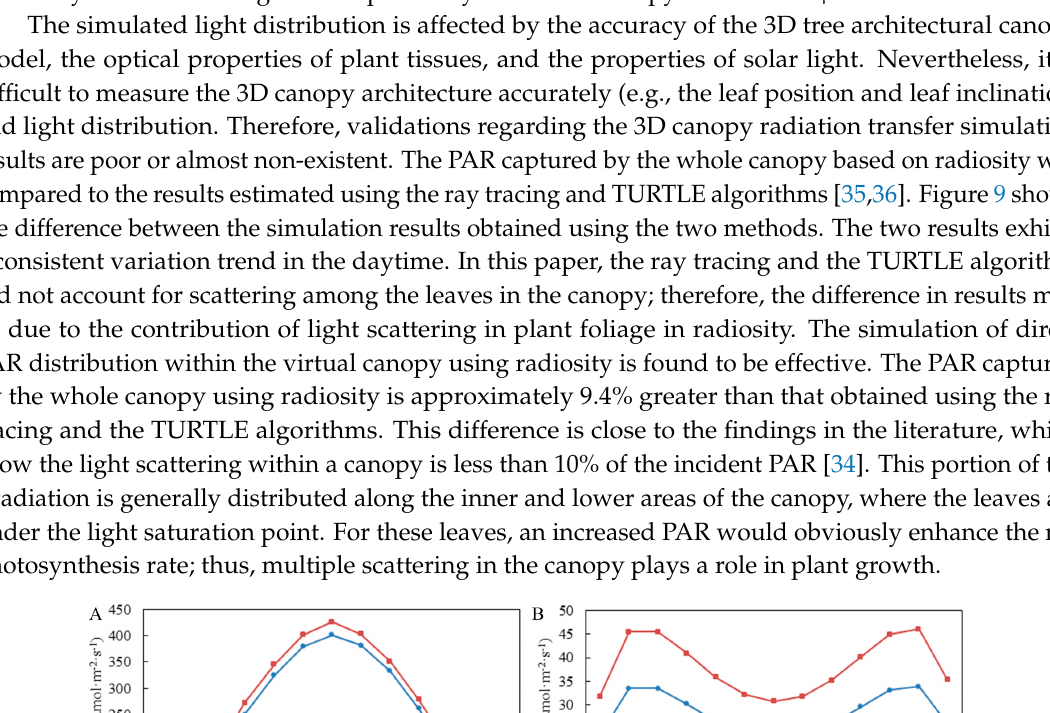
Table 3. Comparison of diffuse sky PAR parameters simulated hourly based on radiosity and the TURTLE algorithm within the loquat canopy.